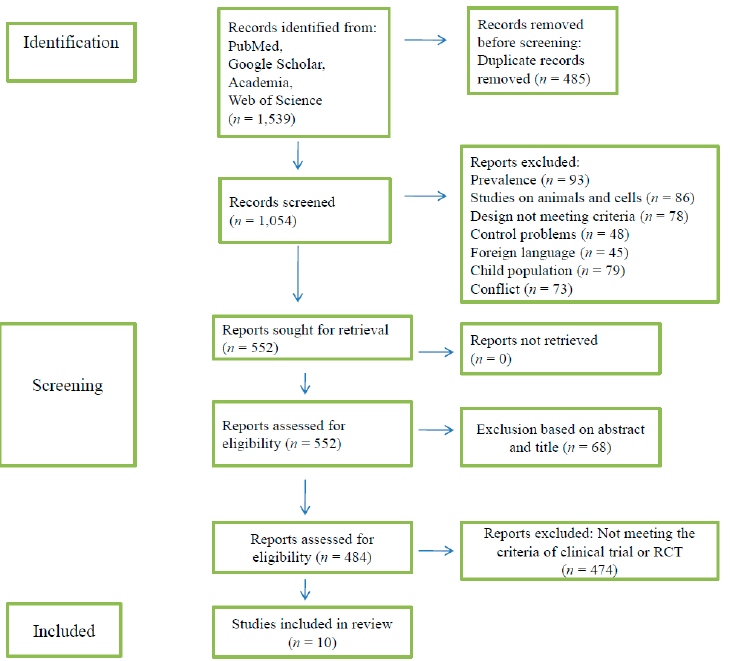
Figure 1. Flow chart for selection of studies on sleep deprivation and weight management.